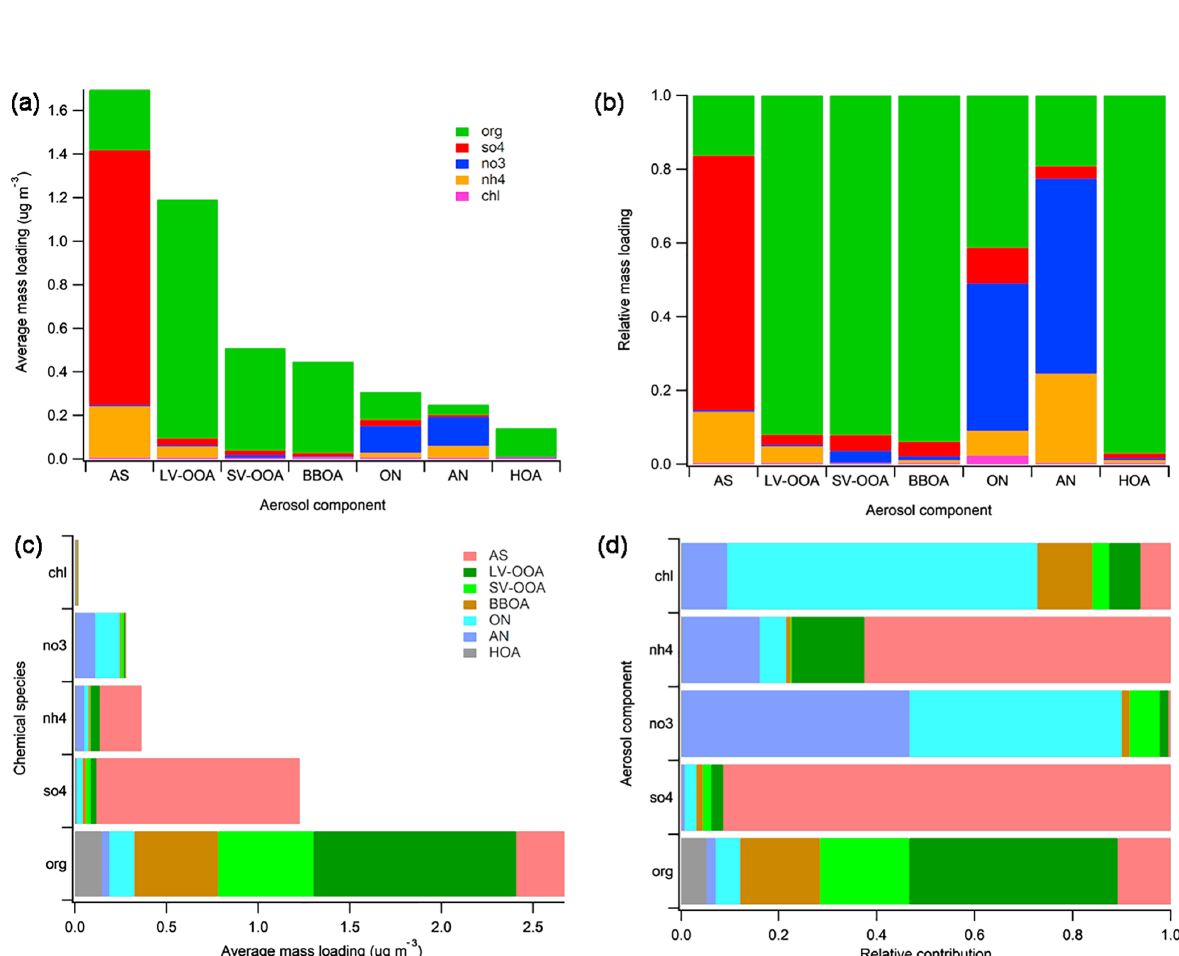
Figure 5. “Default” chemical speciation for r-CMB components: mass loadings (a) and relative contributions (b) of default species in components. Apportionment of default species to r-CMB components by mass (c) and relative contribution (d)